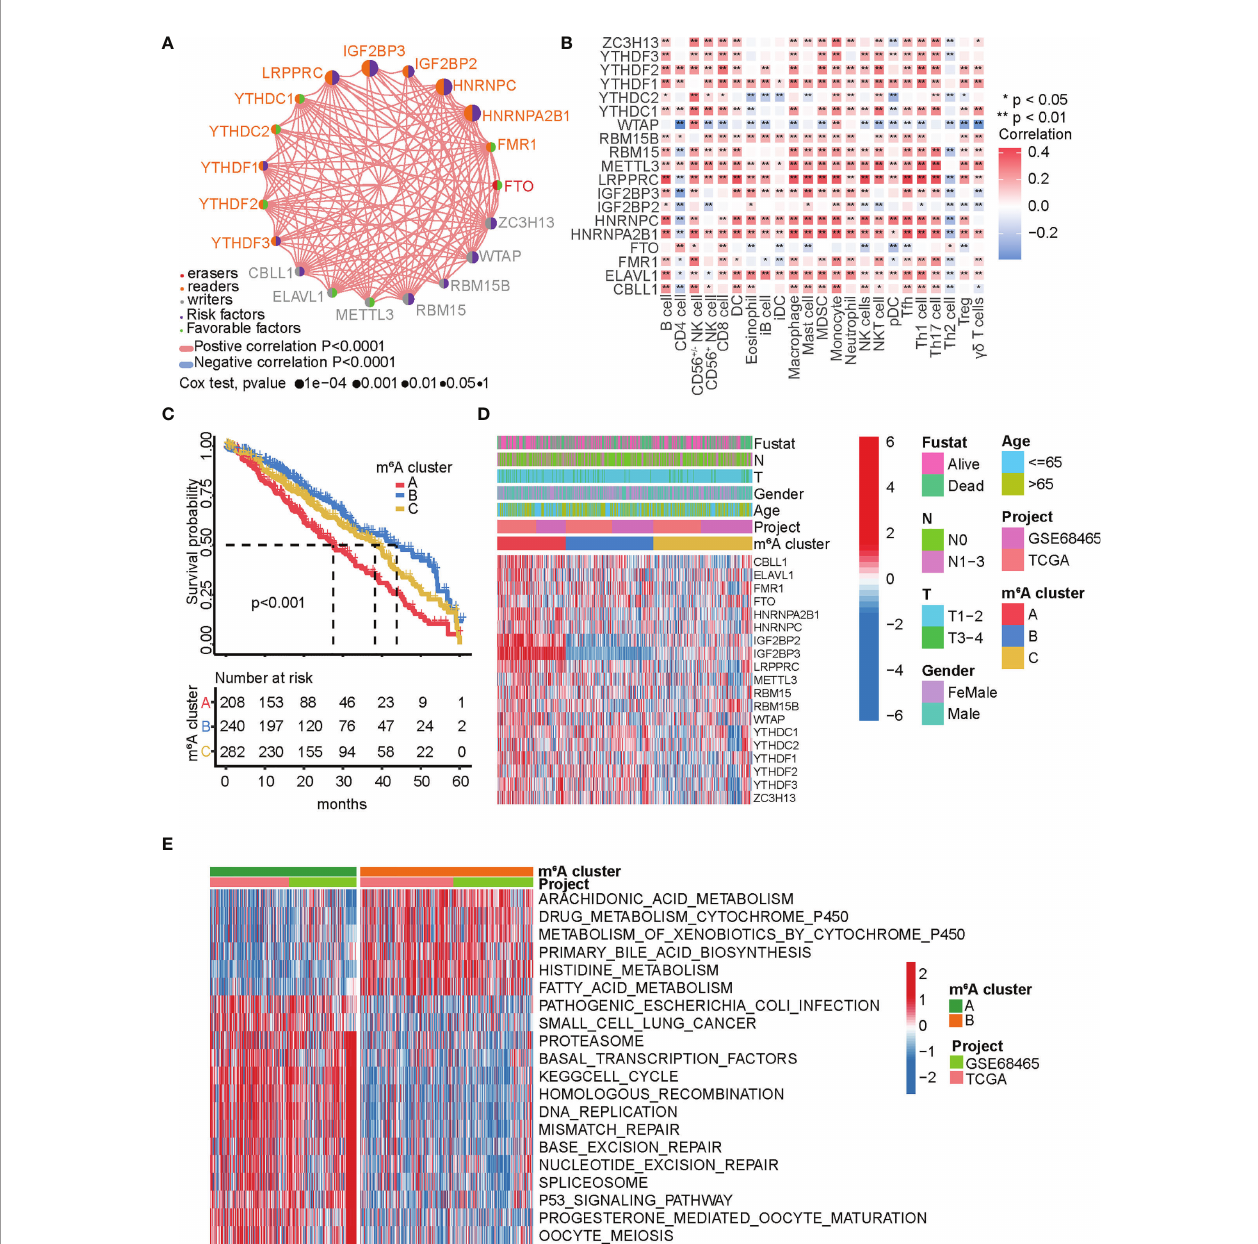
FIGURE 2 | m 6 A methylation patterns and related biological processes. (A) The interplay among the m 6 A regulators in LUAD. The m 6 A regulators in three RNA modi fi cation types were indicated by the different colors in the circle left. Favorable factors for patients ’ survival were indicated by grass green in the circle right and risk factors indicated by blue in the circle right. The circle size indicates the in fl uence of each regulator on prognosis, and the range of values calculated by Log-rank test was represented by the size of each circle. The lines connecting the regulators show their interplay, and the thickness indicates the strength of the association between the regulators. Negative correlation was marked with blue and positive correlation with red. (B) Analysis of the relationship between each tumor-in fi ltrating immune cell type and each m 6 A regulator in LUAD using Spearman ’ s analysis. Red indicates positive correlation; blue indicates negative correlation. * p < 0.05, ** p < 0.01. (C) Survival analyses for the three m 6 A modi fi cation patterns in from TCGA-LUAD and GSE68645, including 208 cases of m 6 A cluster A, 240 cases of m 6 A cluster B, and 282 cases of m 6 A cluster C. Log-rank test, p < 0.0001. (D) Heatmap showing the correlation between the three m 6 A clusters and the clinicopathological characteristics. Clinicopathological information including age, gender, fustat, and tumor stage, as well as the m 6 A cluster, is shown in annotations above. Red represents high expression, and blue represents low expression. (E) Heatmap showing the biological processes in different m 6 A modi fi cation patterns obtained by GSVA enrichment analysis. Red shows activated pathways and blue shows inhibited pathways. m 6 A cluster A vs. m 6 A cluster